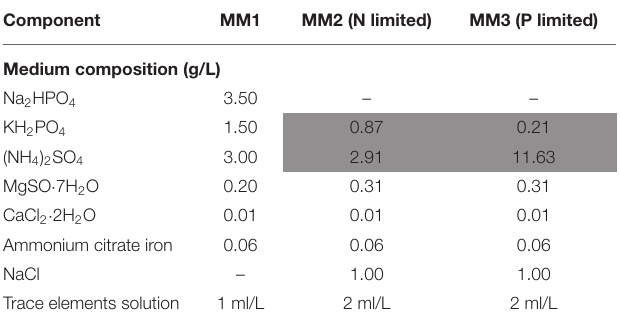
TABLE 1 | Composition of the media used in this work.